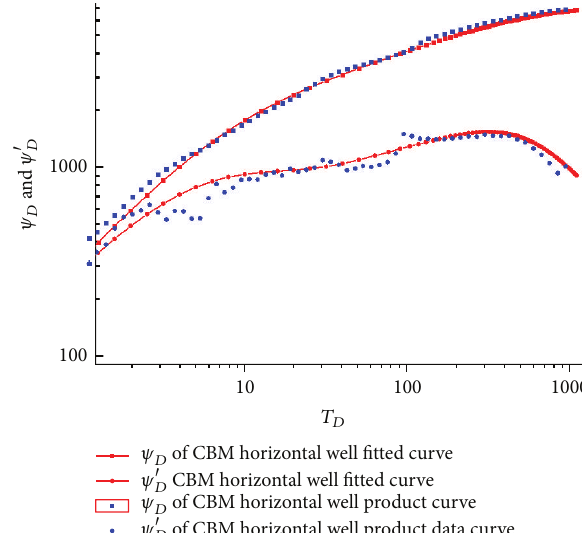
Figure 12: Fitted curves of test data from an actual